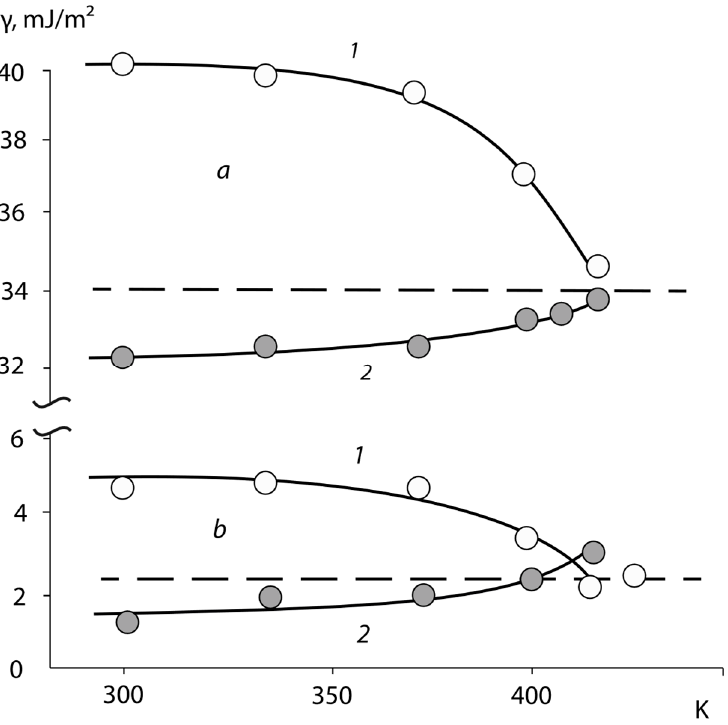
Figure 6. Dependencies γ ( a ), and γ D ( b ) from annealing temperature of vinyl acetate and butyl acrylate copolymers (BAC-50). The copolymer surface is formed in contact with: Al (1), and PTFE (2).